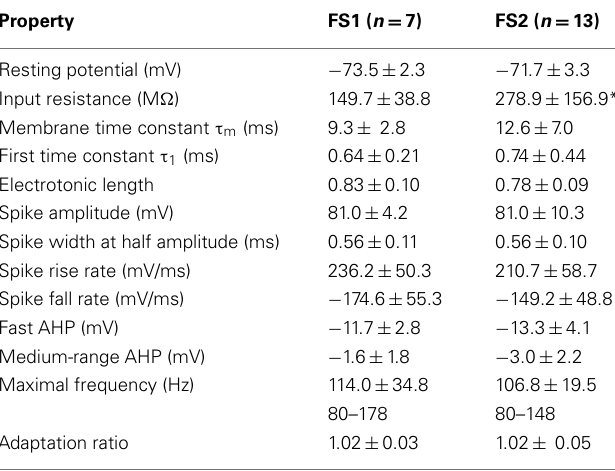
Table 3 | Electrical properties of FS1 and FS2